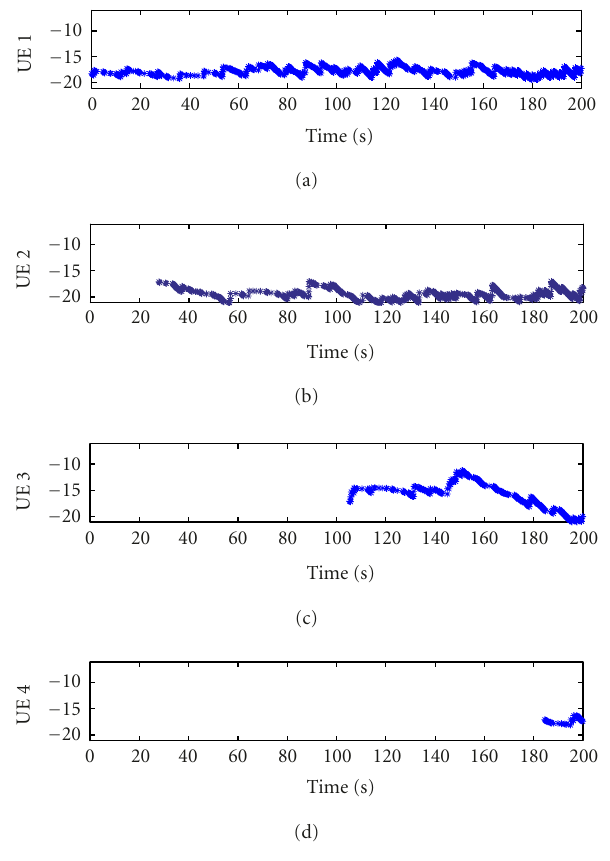
Figure 15: RNC (layer 3) target CIR commands with PIC.